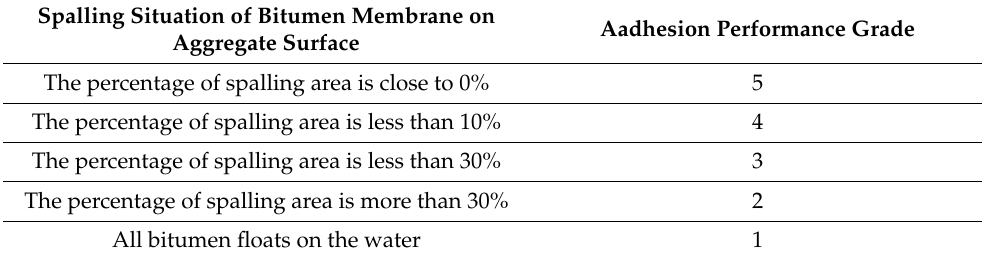
Table 12. Adhesion performance grade between various aggregates and bitumen. Aggregate Limestone Glass Ceramics Adhesion performance grade 3 5 5